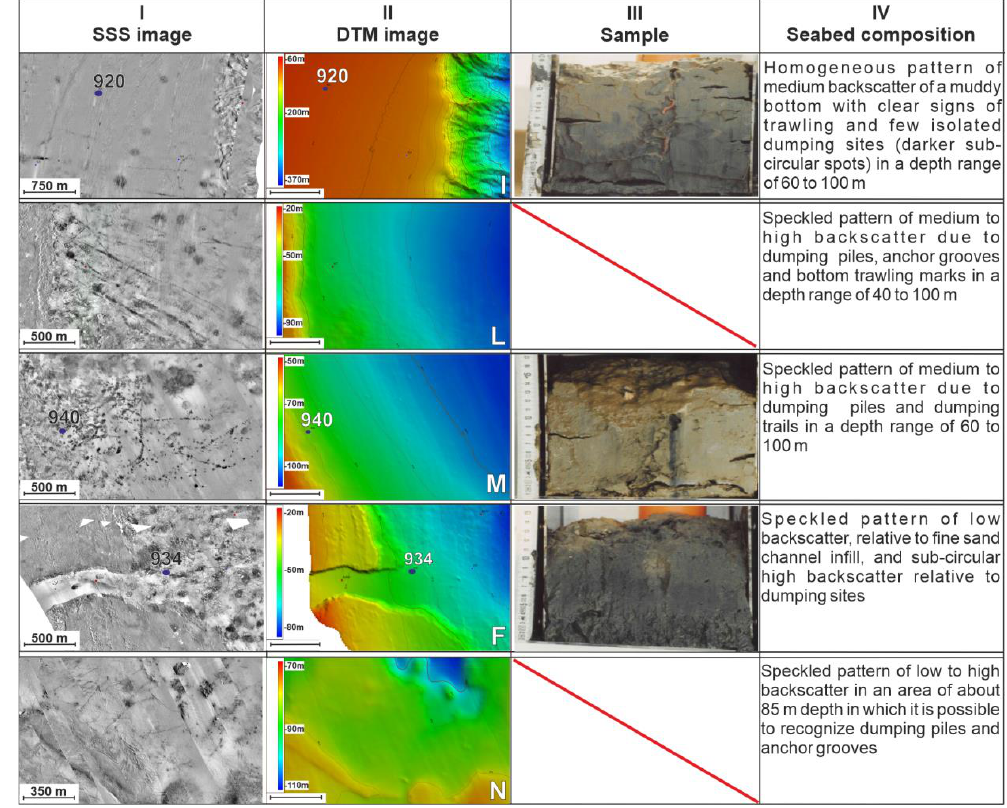
Figure 3. Mosaicked acoustic images of the seabed showing footprints of human activities (I column); SSS mosaic matches the topography of the seabed well (II column); seabed samples serve to calibrate acoustic images (III column); description of the acoustic facies and possible interpretation (IVcolumn). The location of I-N boxes is reported in Figure 2.